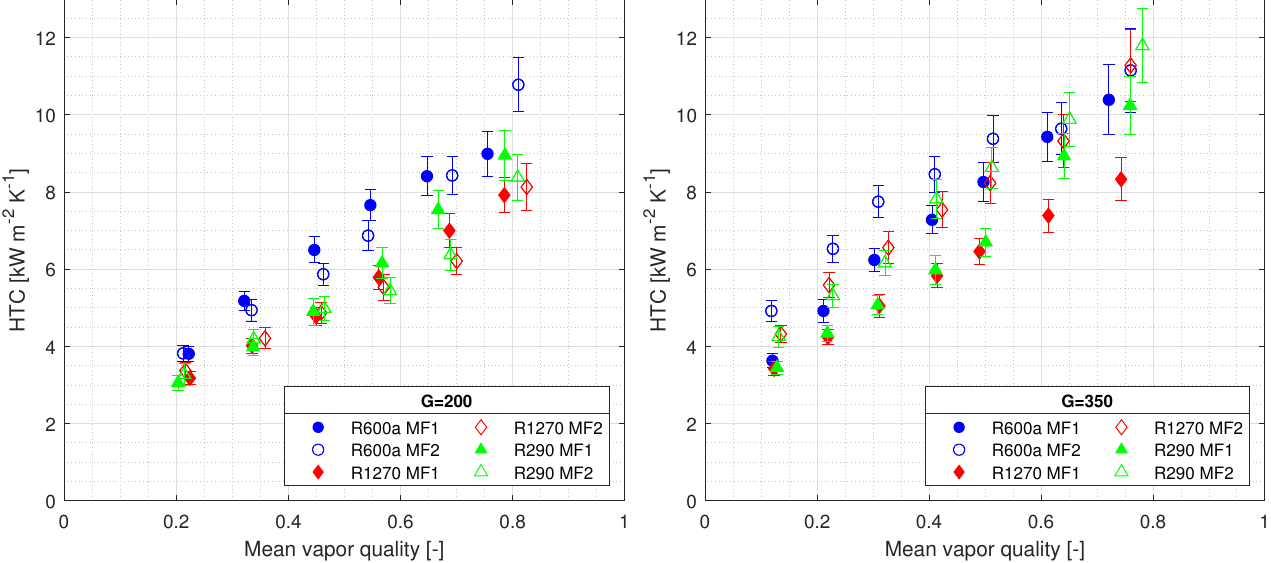
Figure 8. Comparison of HTC in microfinned tubes at different mass fluxes, mass flux (G) reported in the legend in kgm − 2 s − 1